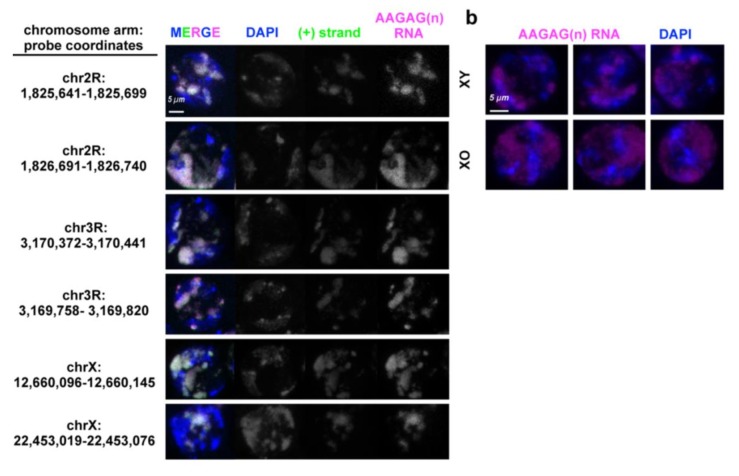
Heterochromatic regions adjacent to AAGAG(n) or AG(n)-rich blocks are transcribed in primary spermatocytes, co-localize with AAGAG(n) RNA foci and do not come from the Y.(a) Projections of Oregon R S5 spermatocytes probed for unique regions of RNA (green) adjacent to AAGAG(n) (magenta) or AAGAG(n) containing AG rich blocks. DAPI (DNA) is indicated in blue. (b) Projections of S5 spermatocyte probed to AAGAG RNA (magenta) imaged at same laser intensities in XY and XO genotypes. DNA is stained with DAPI (blue).